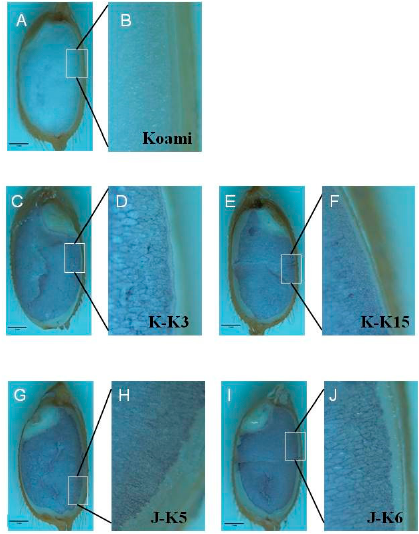
Figure 4. In situ immunohybridization in mature seeds of rice wild-type cultivar Koami ( A , B ) and independent transgenic rice lines overexpressing wheat HMW-GSs. KK-3 and KK-15 transgenic rice lines express HMK-GS 1Dx5_KK ( C – F ) and JK-5 and JK-6 lines express HMK-GS 1Dy10_JK ( G – J ). Each white box region in A, C, E, G and I is scaled up to B, D, F, H and J, respectively. Black scale bar: 1 mm.